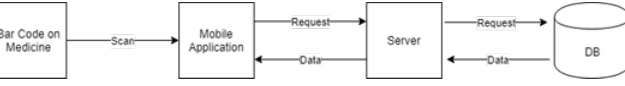
Figure 7. Consumer side block diagram